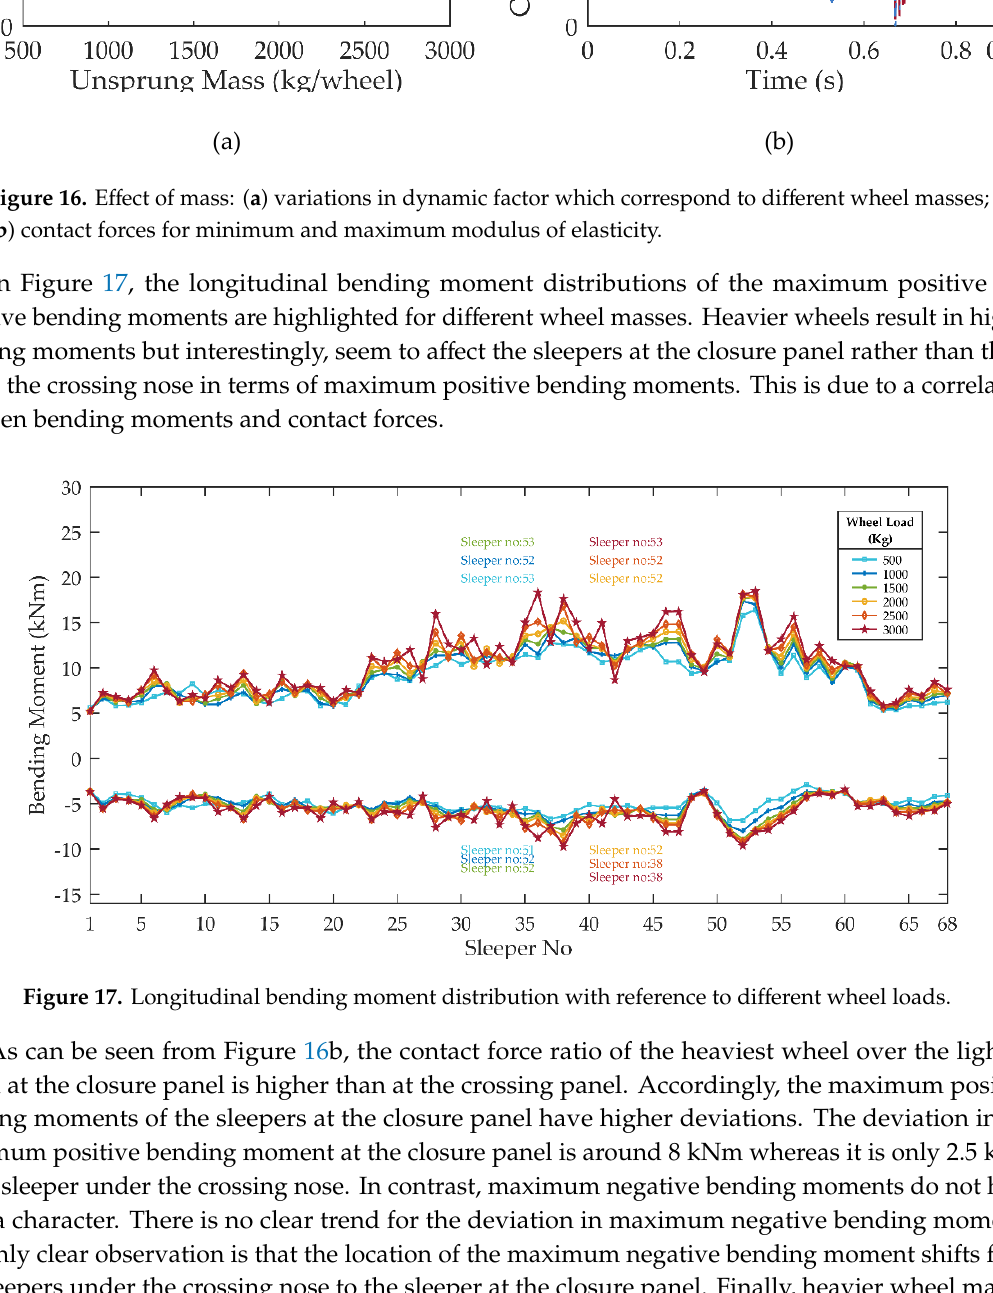
18 of 24 Figure 15. Bending moment distributions of specific sleepers with reference to different sleeper types: ( a ) sleeper at the entrance; ( b ) sleeper under the switch blades; ( c ) sleeper at the closure panel; ( d ) sleeper under the crossing nose; ( e ) the longest sleeper; ( f ) the shortest sleeper. 3.2.4. Effects of Unsprung Masses The effective masses in the wheel‐rail interaction are the unsprung (wheel) masses [6]. The effects of different unsprung masses are considered in the parametric study. The effects of the unsprung masses on both contact forces and the dynamic factor are presented in Figure 16. The dynamic factor corresponding to different wheel loads reveals an unexpected phenomenon. The reason is the definition of the dynamic factor, the maximum force (impact force) over static force. It could be inferred from the figure, that the impact forces increase with higher wheel masses and reach a horizontal asymptote. In other words, the impact forces become gradually less sensitive to higher wheel masses; in the meantime, static force always increases with wheel mass. As a